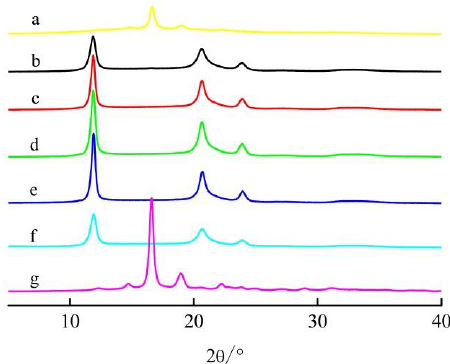
Figure 3. XRD curves of PLLA, PDLAG-5%, and sc-PLAG samples with di ff erent glucose content in feeding; the glucose content in the feeding of samples: a. PDLAG-5%; b. 5%; c. 4%; d. 2%; e. 1%; f. 0.5%; g.